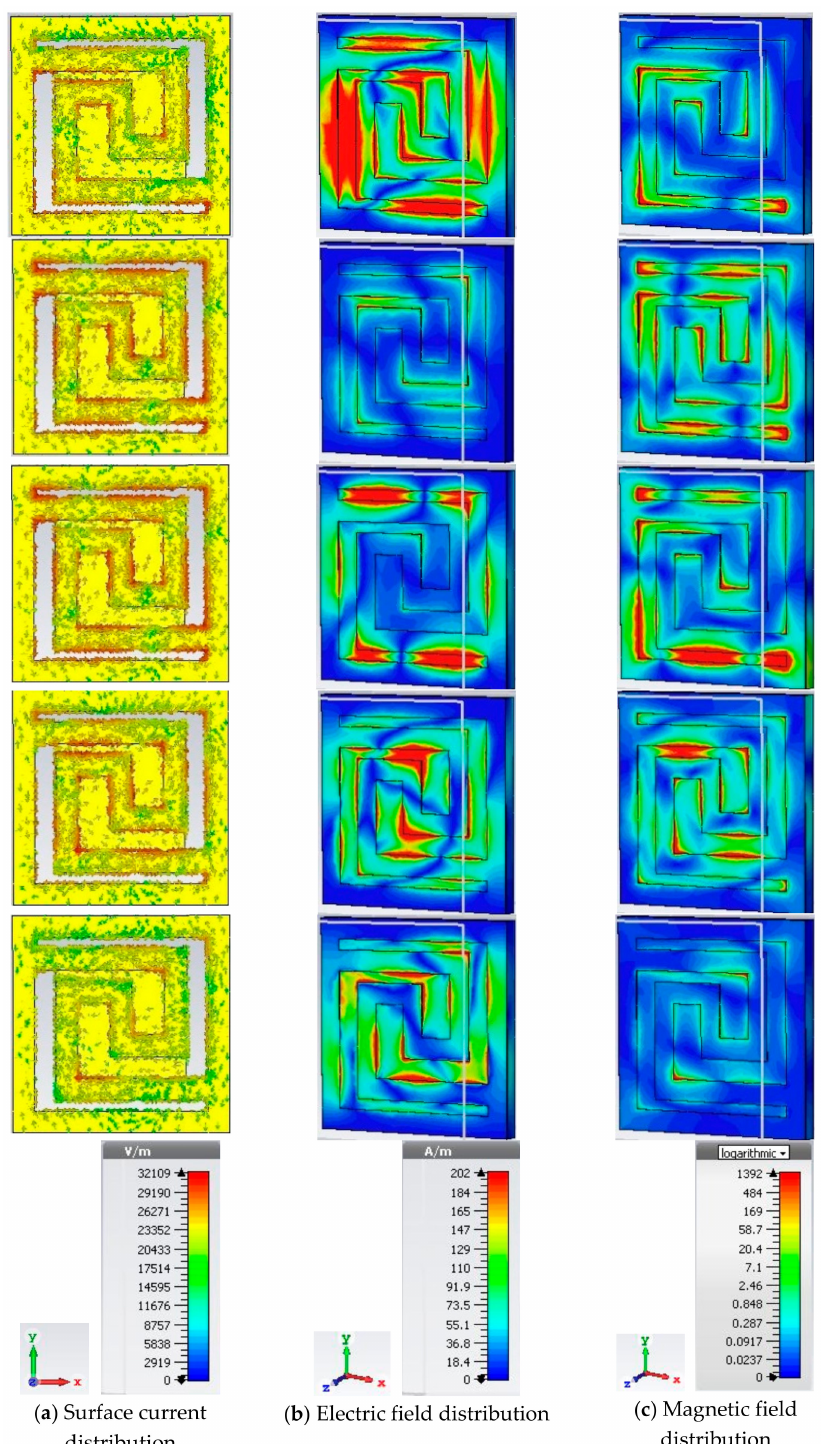
Figure 9. Instantaneous distribution of ( a ) surface current, ( b ) electric field, and ( c ) magnetic field at 14.64, 18.24, 21.2, 24.62, and 26.15 GHz, respectively, for Rogers 3035